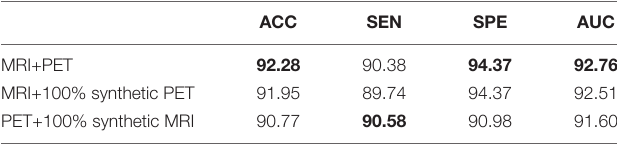
TABLE 9 | The AD vs. CN classification experiment uses synthetic full data and real full